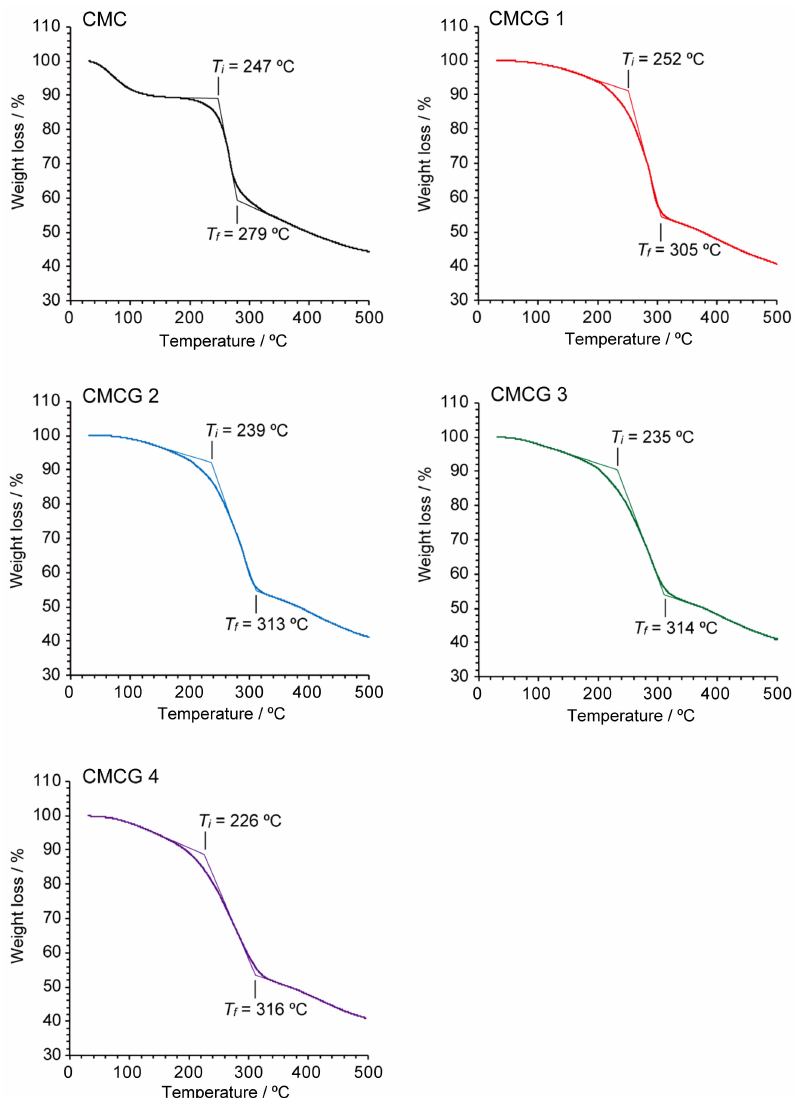
Figure 9. The initial ( T i ) and final ( T f ) degradation temperatures for the second stage of thermal decomposition for CMCG 1–4 and CMC determined by thermogravimetric analysis (Figure 8,